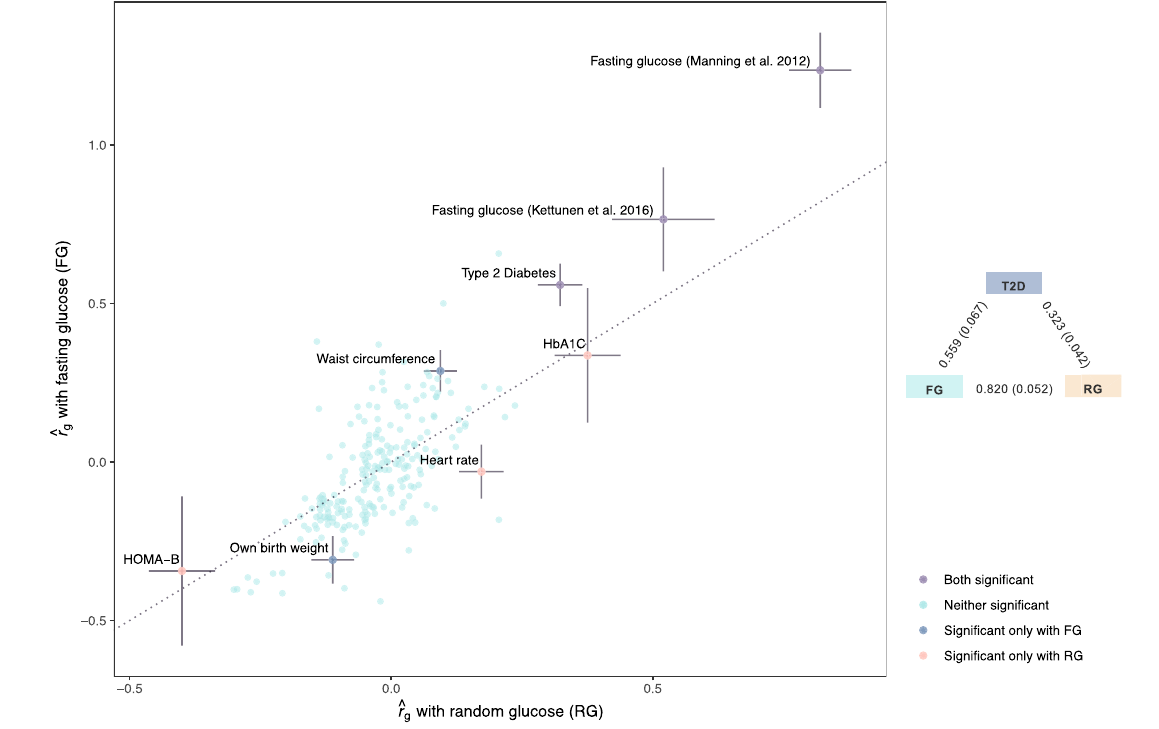
Fig. 2 | Estimates of genetic correlation between random glucose/fasting glu- cose and 245 traits in LD Hub. The genome-wide genetic correlations were esti- matedusingLDSCregression.Thex-axisrepresents r g estimatesobtainedthrough meta-GWASof RG in UKB, and the y-axis represents r g estimates obtained through GWAS summary statistics of FG from Lagou et al. (2021). Of the traits analyzed, eight showed r g estimates with either RG or FG that passed the multiple testing signi fi cance threshold (two-sided P -value<0.05/245, or a Bonferroni corrected P -